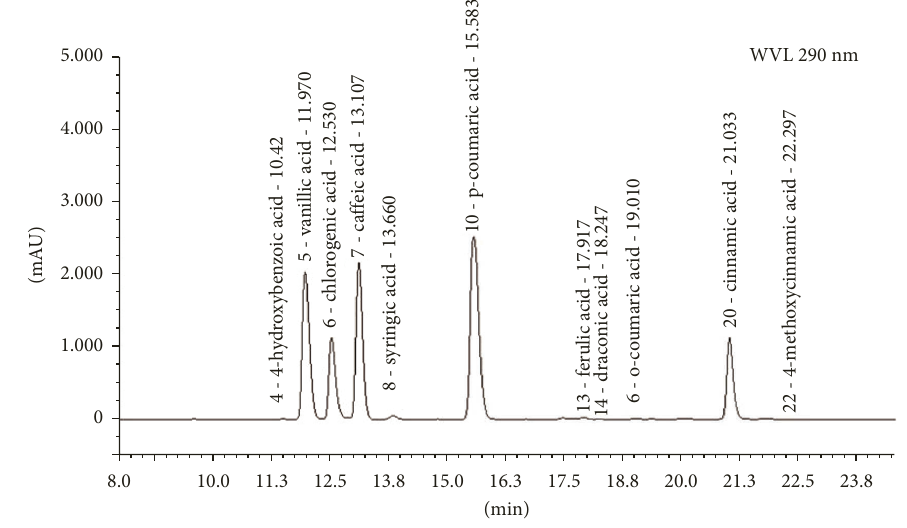
Figure 1: HPLC-UV standards chromatogram at